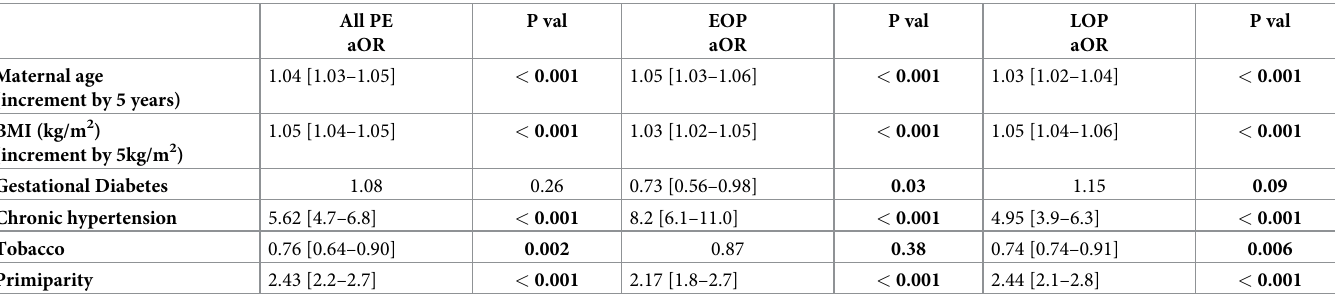
Table 2. Logistic multivariate regression analysis. All PE (all preeclampsia N = 1,736), EOP (N = 574) and LOP (N = 1,162) vs controls, no preeclampsia (N =